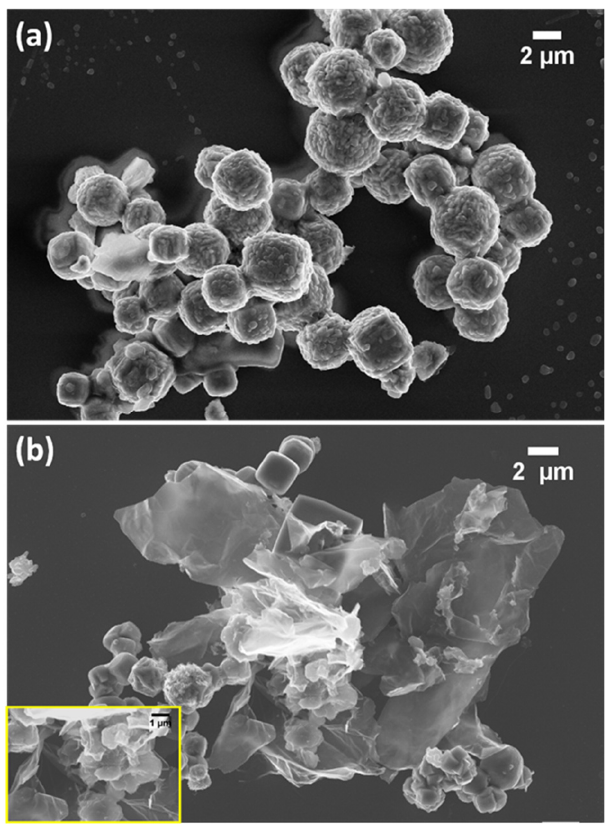
Figure 2. FESEM images for ( a ) pristine FNS and ( b ) FNS@GC composite powder (inset shows the magnified version of the FESEM image).